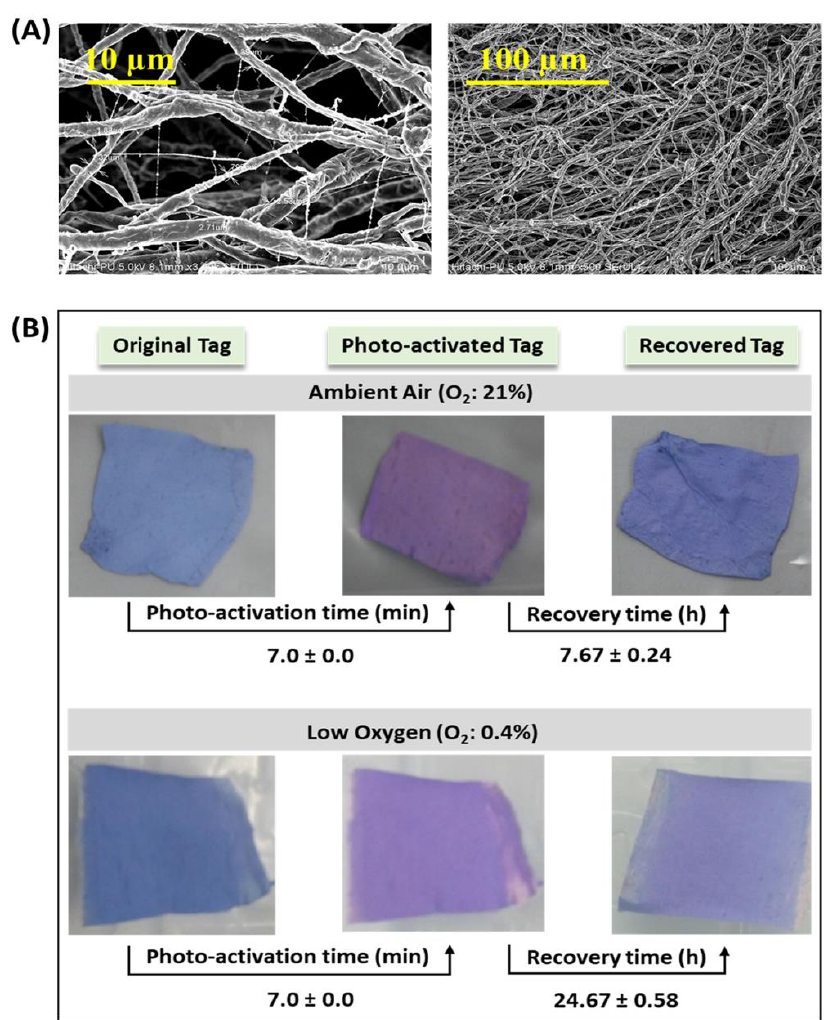
Figure 4. Microstructure and appearance of electrospun tag as affected by ultraviolet light activation: ( A ) microstructure; ( B ) original, photo-activated, and recovered tags.